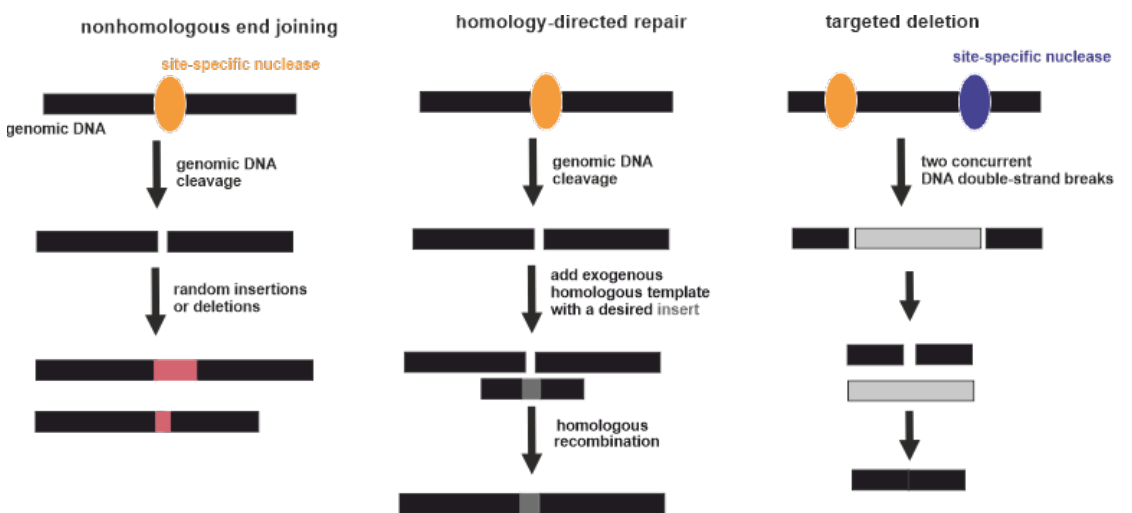
Figure 3. Three types of gene-specific manipulations. Black boxes indicate genomic DNA. Yellow and violet ellipses indicate site-specific nucleases. Pink boxes indicate random insertions or deletions acquired during nonhomologous end joining. Dark grey box indicates a desired insert acquired during homology-directed repair. Light grey box indicates excised part of genomic DNA between two DNA double-strand breaks.